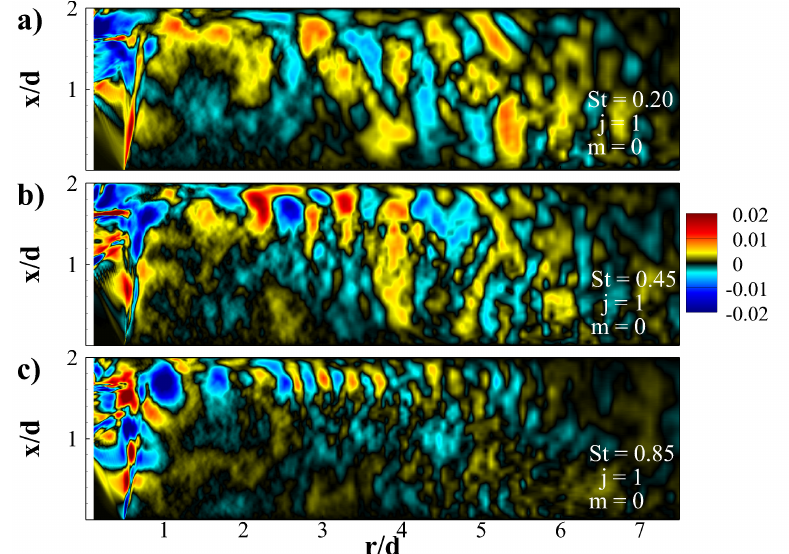
Figure 10. Streamwise velocity field of the first SPOD mode of the axisymmetric azimuthal mode for different Strouhal numbers of ( a ) St = 0.20; ( b ) 0.45; and ( c )